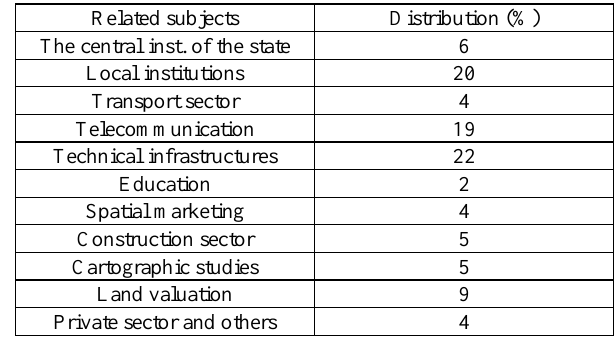
Table 4. Related subjects with distributions (%) for spatial information system. (Köktürk, E. and Köktürk, E. 2002). There are some steps for information systems of data processing in Table 5. in below.